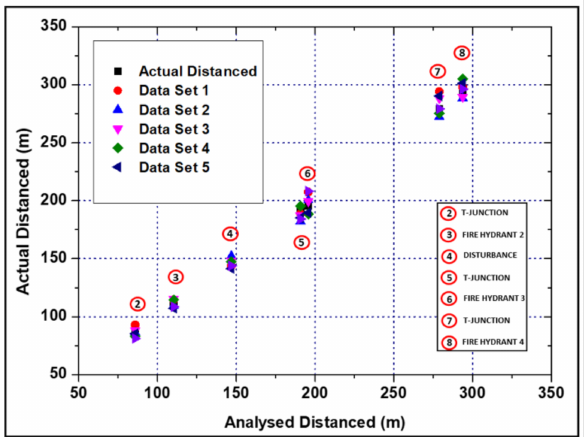
Figure 28. Scatter plot on repetition for 5 mm leak induced on fire hydrant 1 and 2 pipeline system